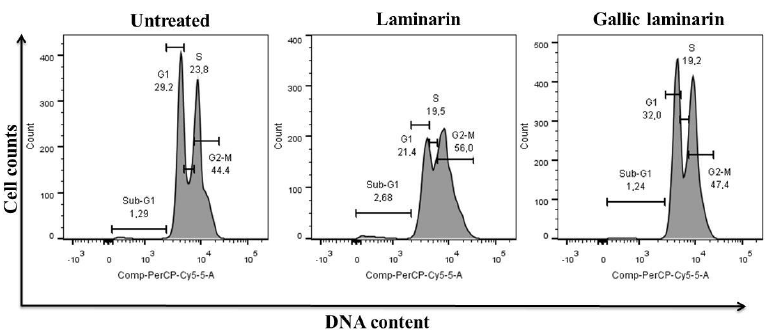
Figure 11. Flow cytometric analysis of MDCK cells stained with PI ( y -axis) shows the distribution of cells in each cell cycle. Sub-G1 population: indicates cell death from DNA damage; G1 population indicates live cells in G1 phase, population S indicates cells going through the synthesis phase, and G2/M indicates cells in the G2 phase proceeding toward cell division.